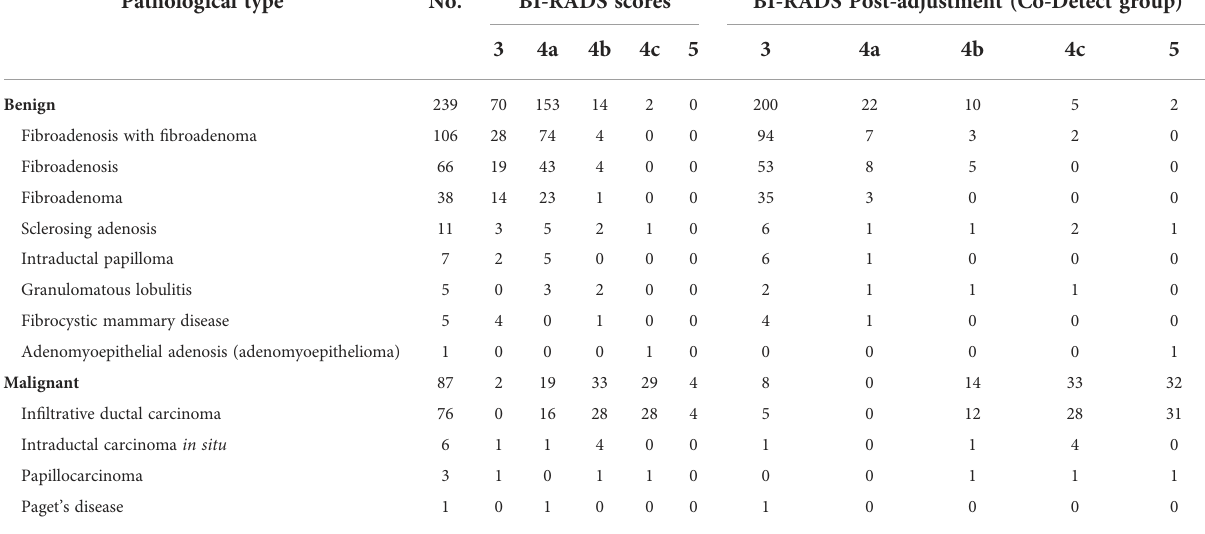
TABLE 1 Pathological results and BI-RADS scores of lesions